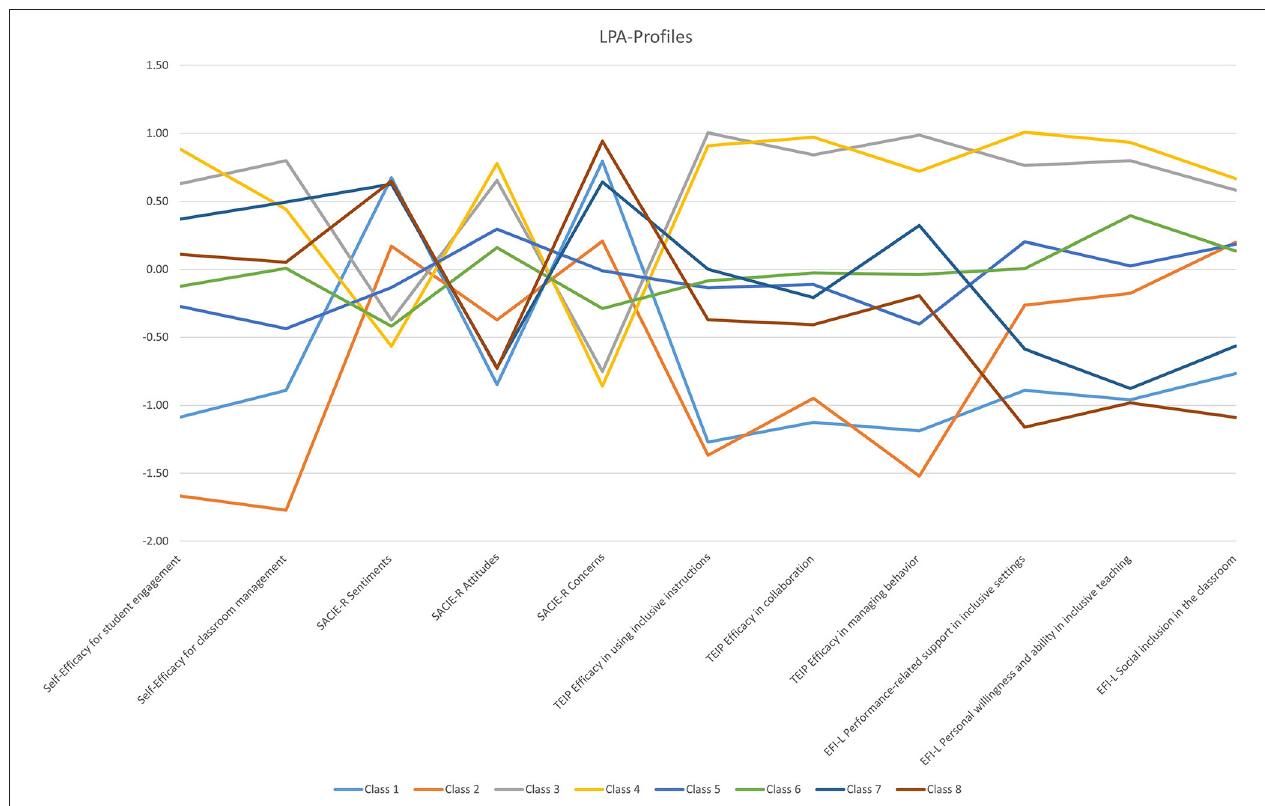
FIGURE 1 | Diagrammatic representation of the eight identified patterns, four classes, 11 indicators examined by latent profile analysis, and logarithmic scale for comparison reasons.